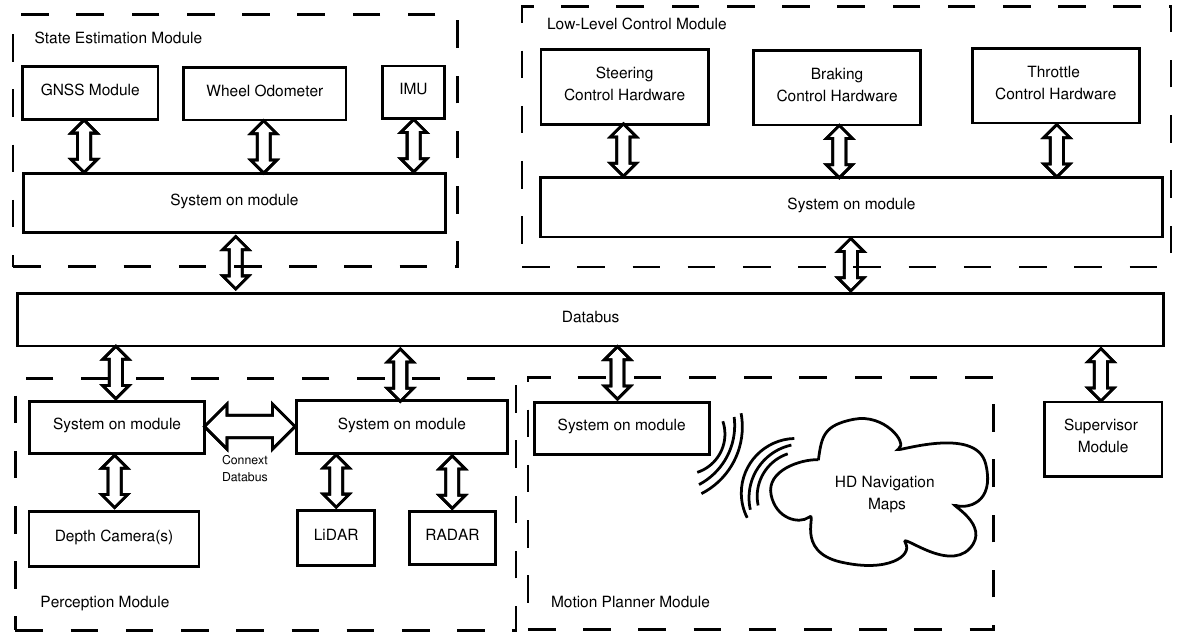
Figure A1. Proposed architecture for an autonomous test